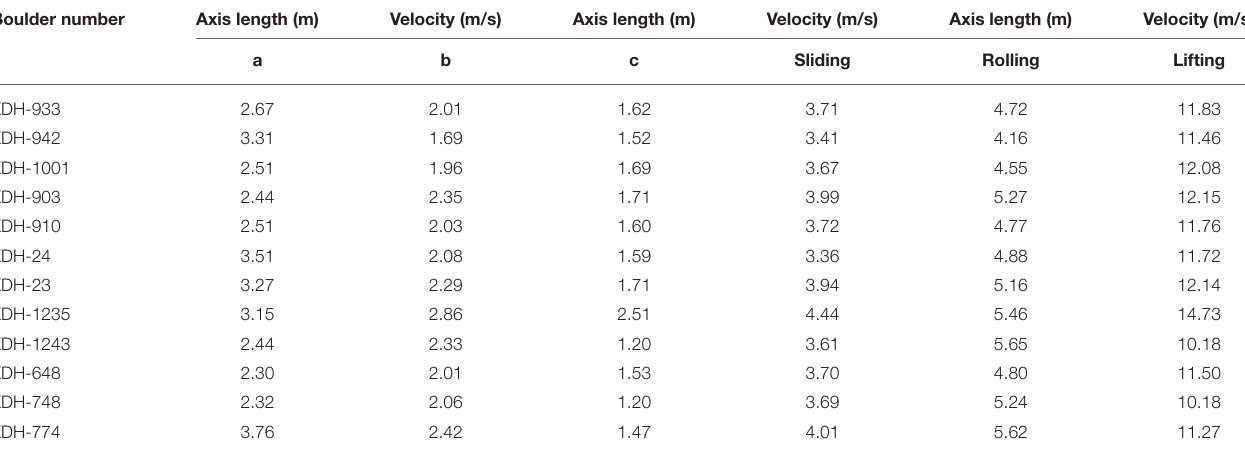
TABLE 5 | Results from hydrodynamic equations showing the calculated minimum velocities capable of moving the largest 12 boulders. Boulder number Axis length (m) Velocity (m/s) Axis length (m) Velocity (m/s) Axis length (m) Velocity (m/s) a b c Sliding Rolling Lifting XDH-933